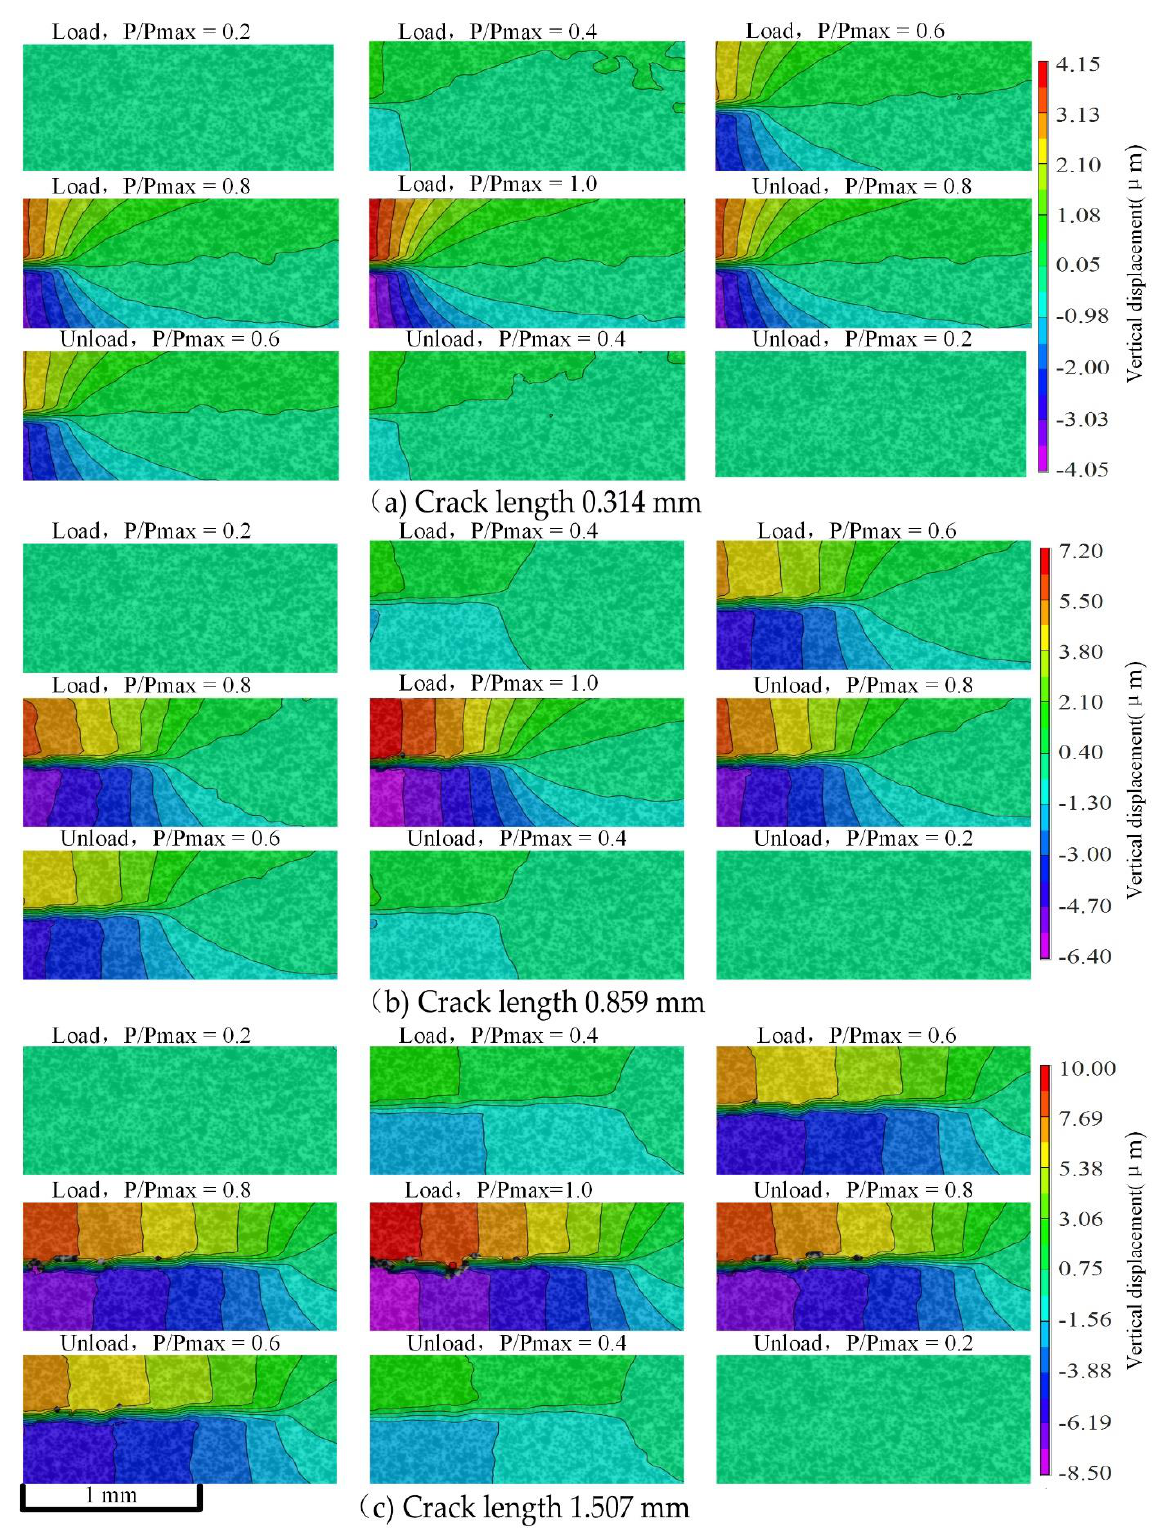
Figure 10. The vertical displacement fields in a load cycle at different crack lengths when the stress ratio is 0.4.